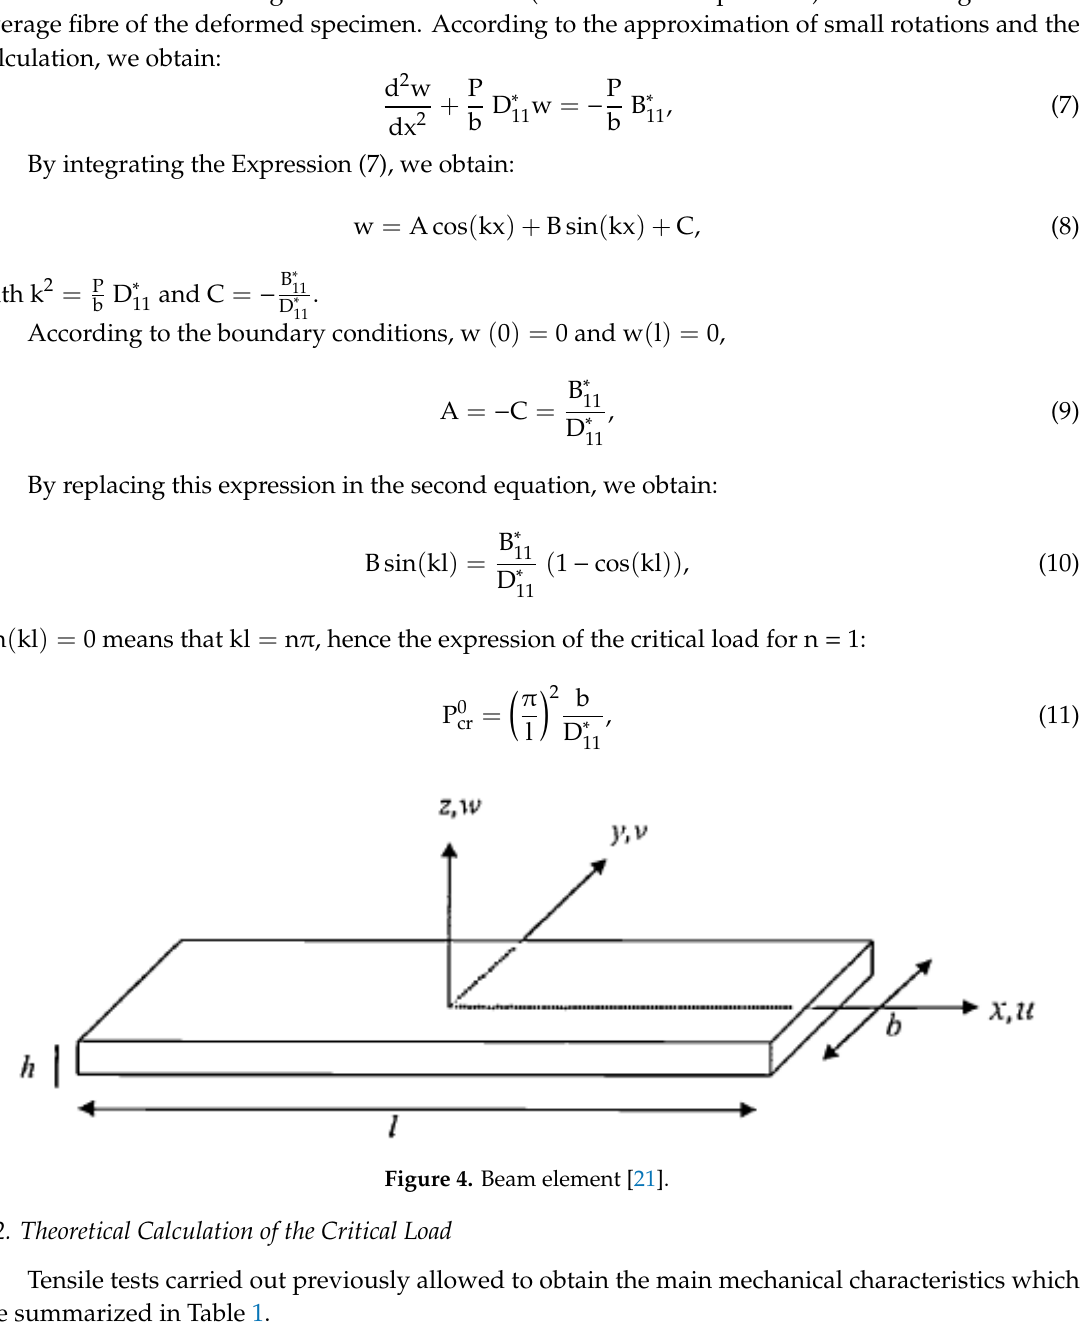
Table 1. Mechanical characteristics of laminated flax/epoxy . Mechanical